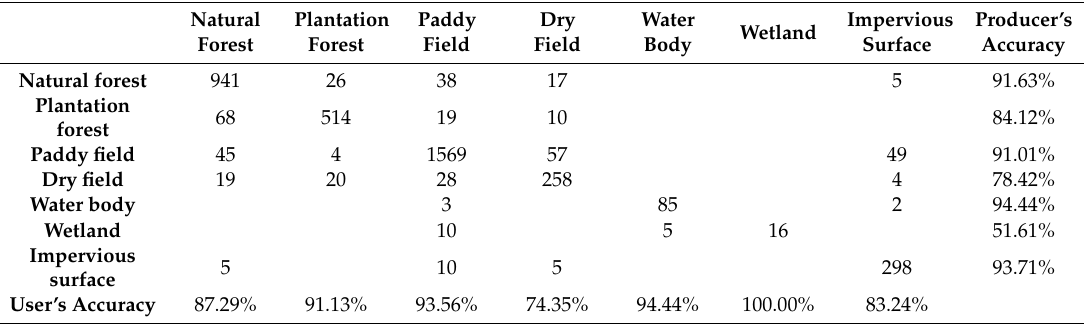
Table 6. Confusion matrix for SBTMC